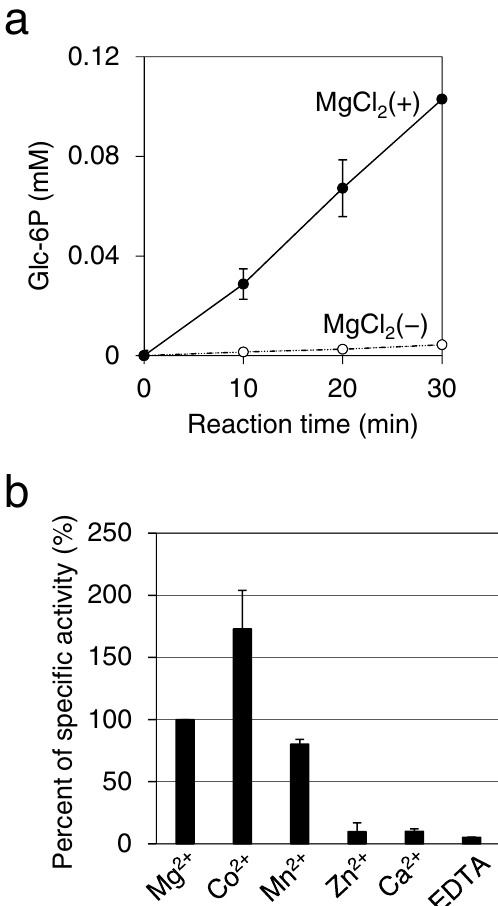
Figure 1. Assay of Glc phosphorylation activity of YLR446Wp. ( a ) The enzyme activity of YLR446Wp for glucose phosphorylation was monitored using a glucose-6-phosphate dehydrogenase-coupled assay. The reaction of glucose phosphorylation with Ngk1 was assessed in the presence (+) or absence (−) of MgCl 2 . ( b ) The specific activity for glucose phosphorylation in the presence of either MgCl 2 , CoCl 2 , MnCl 2 , ZnCl 2 , CaCl 2 , or EDTA was compared. The percentage of the specific activity in the presence of MgCl 2 was set as 100%. Error bars, the standard deviation of two independent